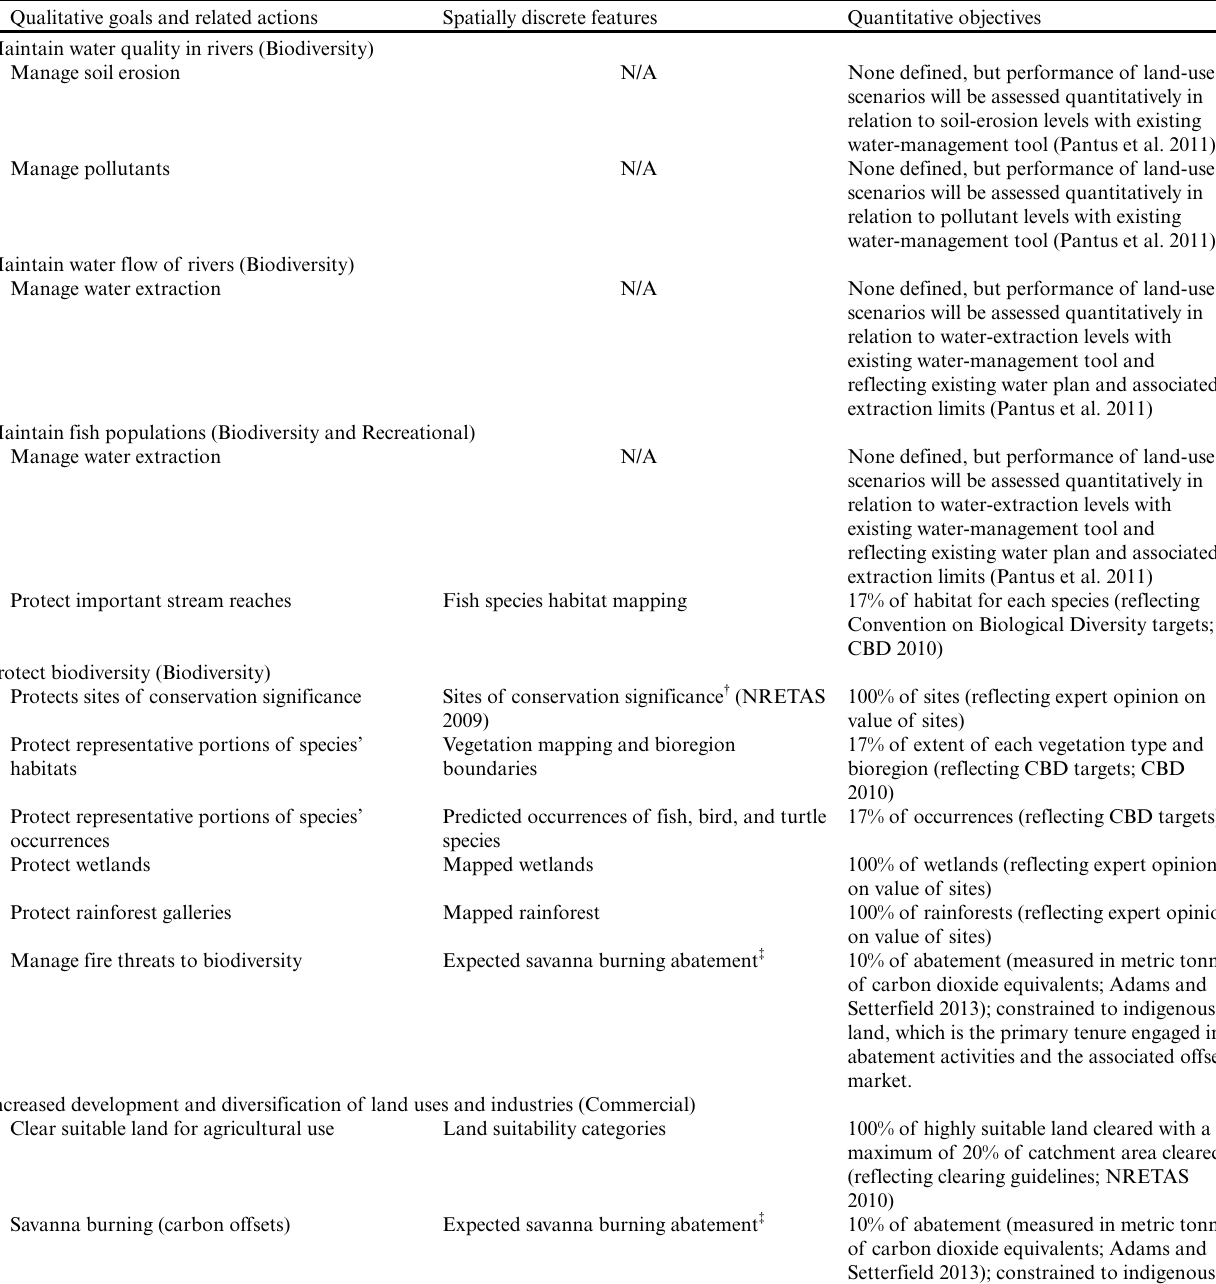
Table 1 . Qualitative goals related to well-being identified through the objective-setting process with the Daly River Management Advisory Committee (DRMAC). Each broad qualitative goal was mapped to one or more of the four well-being domains that focus groups identified. Under each goal, the associated actions, available mapped features, and spatial, quantitative objectives are listed. N/ A indicates that there were no available map